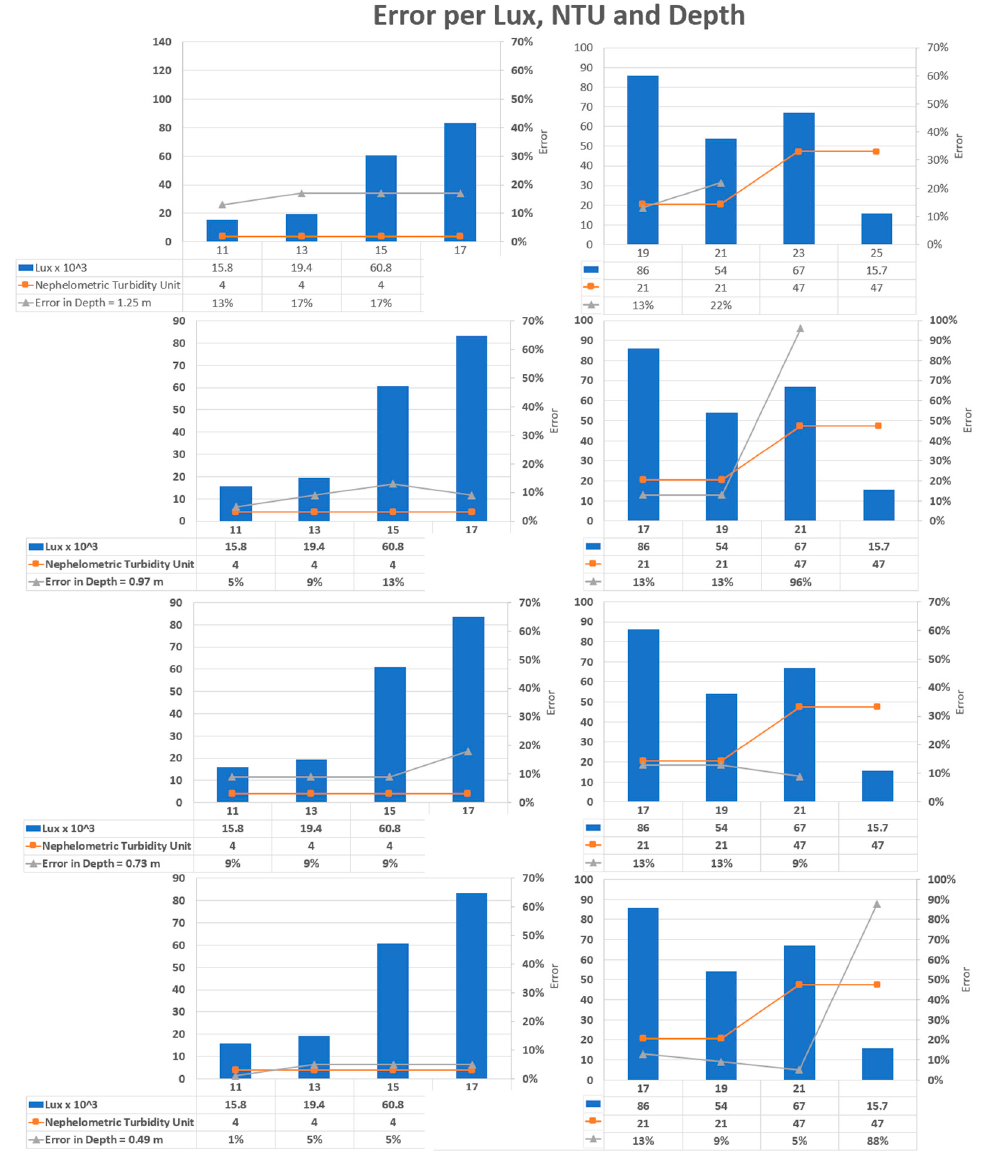
Figure 9. Assessment of the errors found at different depths, considering the variation in luminosity and turbidity during the surveys.